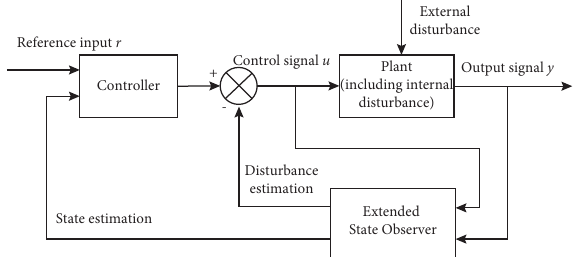
Figure 5: Te state-space diagram of